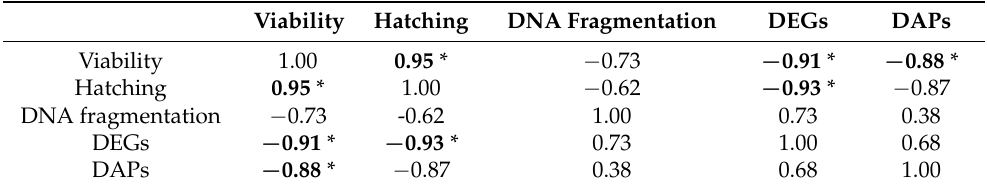
Table 2. Correlation between parameters analyzed in the current study on sterlet ( A. ruthenus ) embryos. The correlation coefficients between % viability, hatching rate, DNA fragmentation, number of differentially expressed genes (DEGs), and number of differentially abundant proteins (DAPs) were measured by Spearman’s test. The t -test is used to establish the significance of the correlation between pairs of parameters. Asterisks indicate p < 0.05. Viability Hatching DNA Fragmentation DEGs DAPs Viability 1.00 0.95 * − 0.73 − 0.91 * − 0.88 * Hatching 0.95 * 1.00 − 0.62 − 0.93 * − 0.87 DNA fragmentation − 0.73 -0.62 1.00 0.73 0.38 DEGs − 0.91 * − 0.93 * 0.73 1.00 0.68 DAPs − 0.88 * − 0.87 0.38 0.68